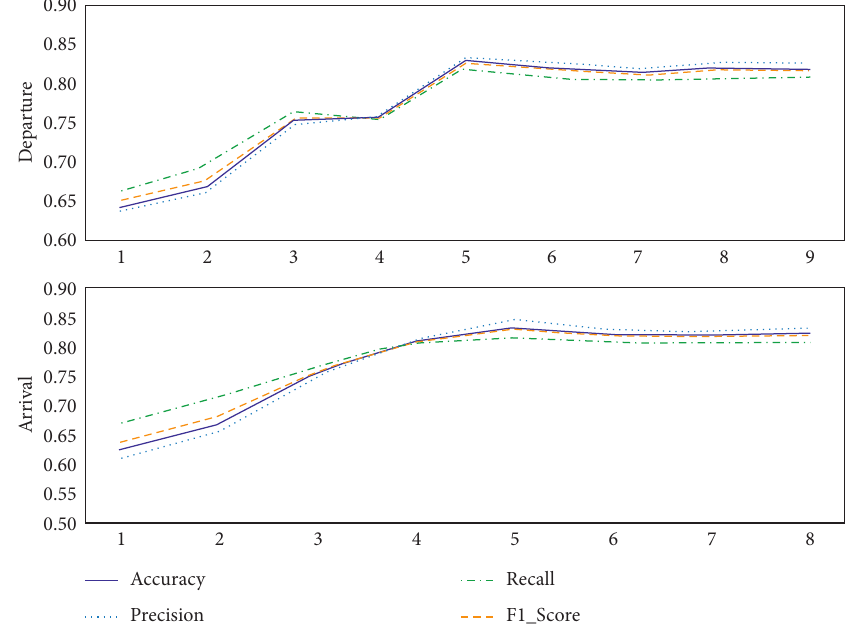
Figure 6: The prediction results with different